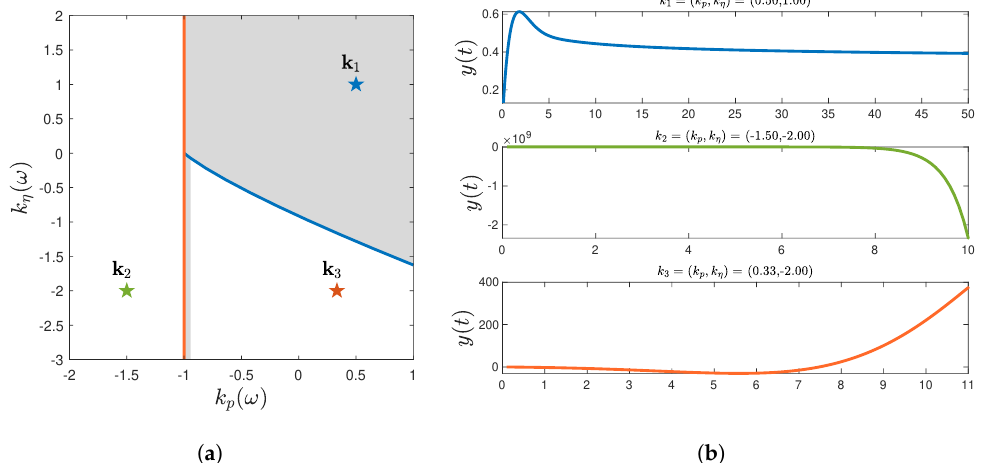
Figure 5. Stability analysis of system (13). ( a ) Stability region (gray) of the closed-loop system with µ = 0.4. ( b ) Time response for control gains inside different regions on the parameter’s